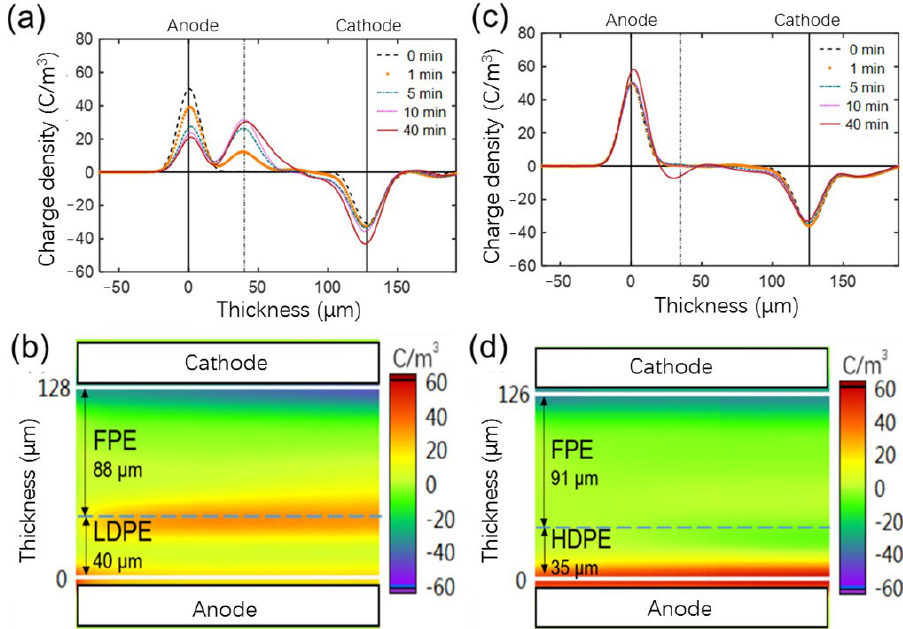
Figure 16. Space charge distribution of unaged ( a , b ) LDPE(P)/FPE(N) and ( c , d ) HDPE(P)/FPE(N) polarized for 40 min under − 50